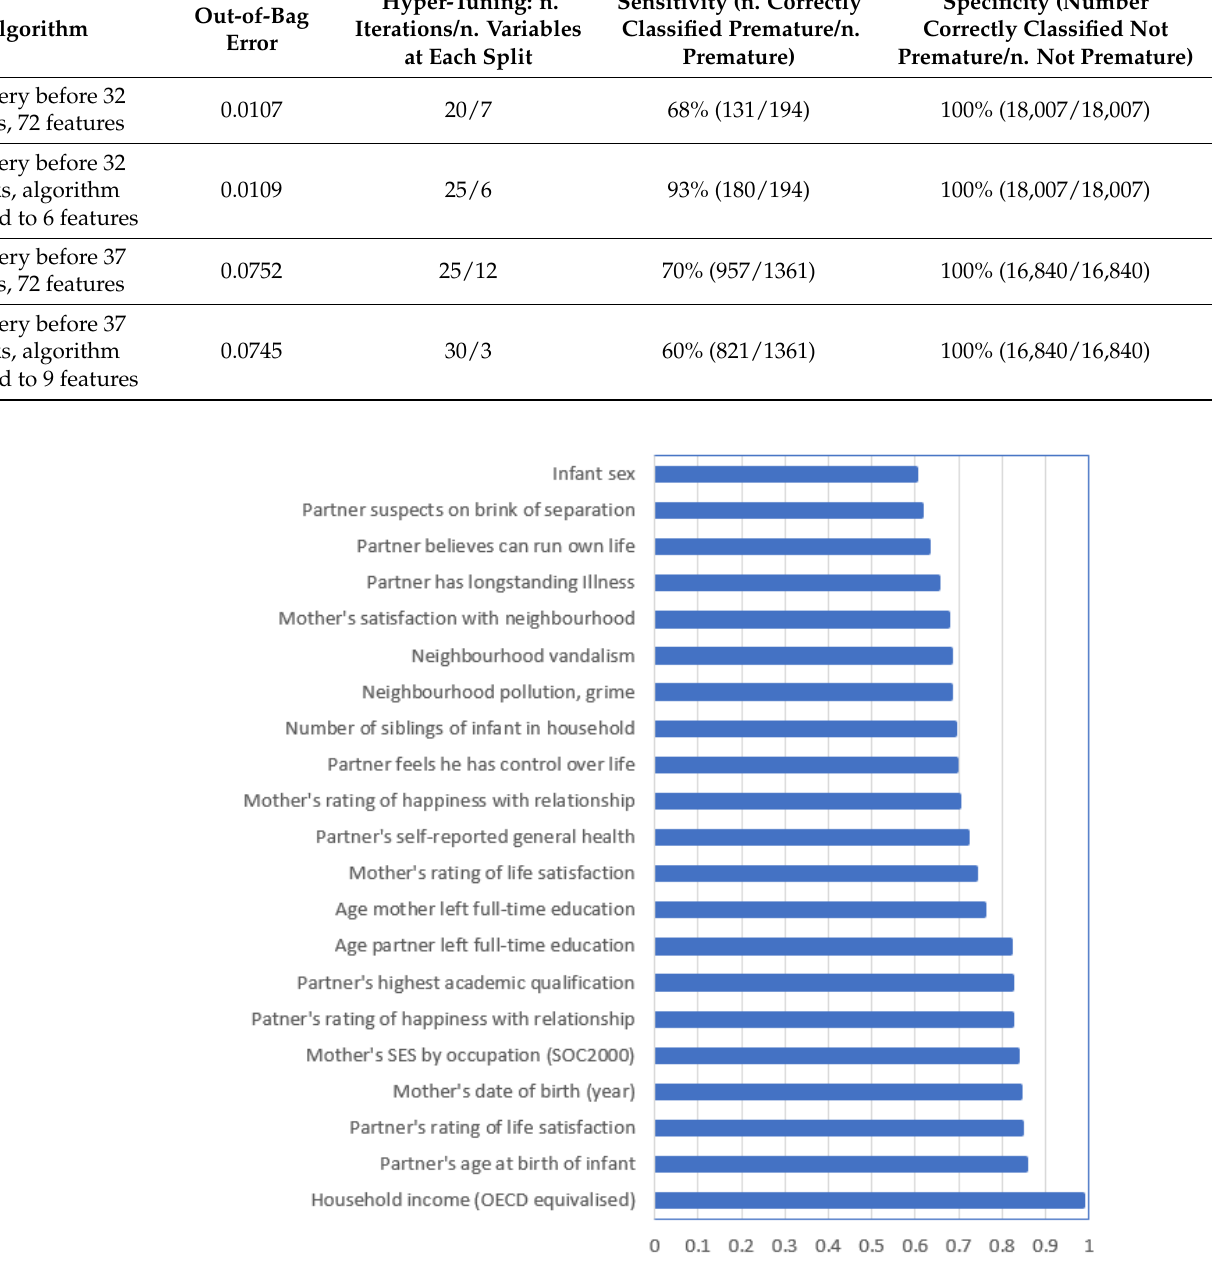
Figure 2. Importance scores for features with average importance scores above 0.6 in 72-feature RF algorithms predicting premature birth before 37 weeks.